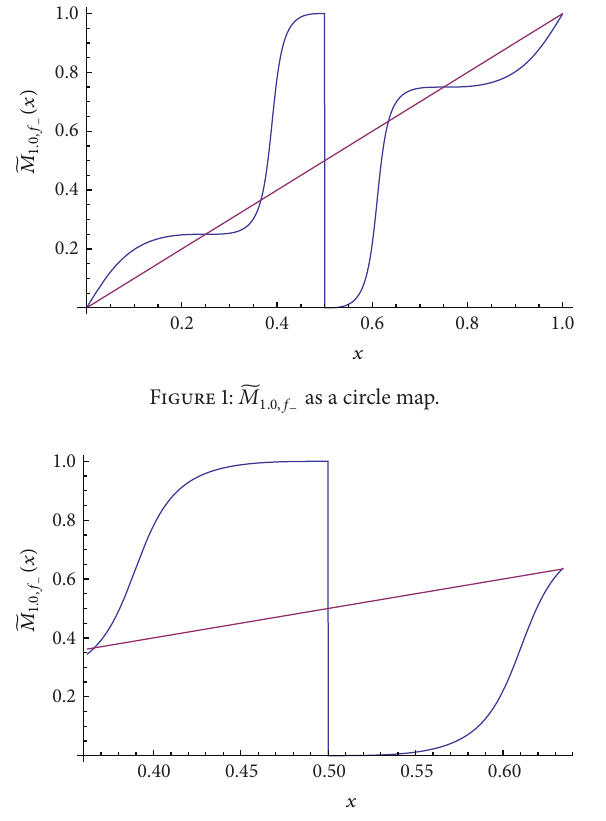
̃𝑀 1.0,𝑓 − restricted to the interval